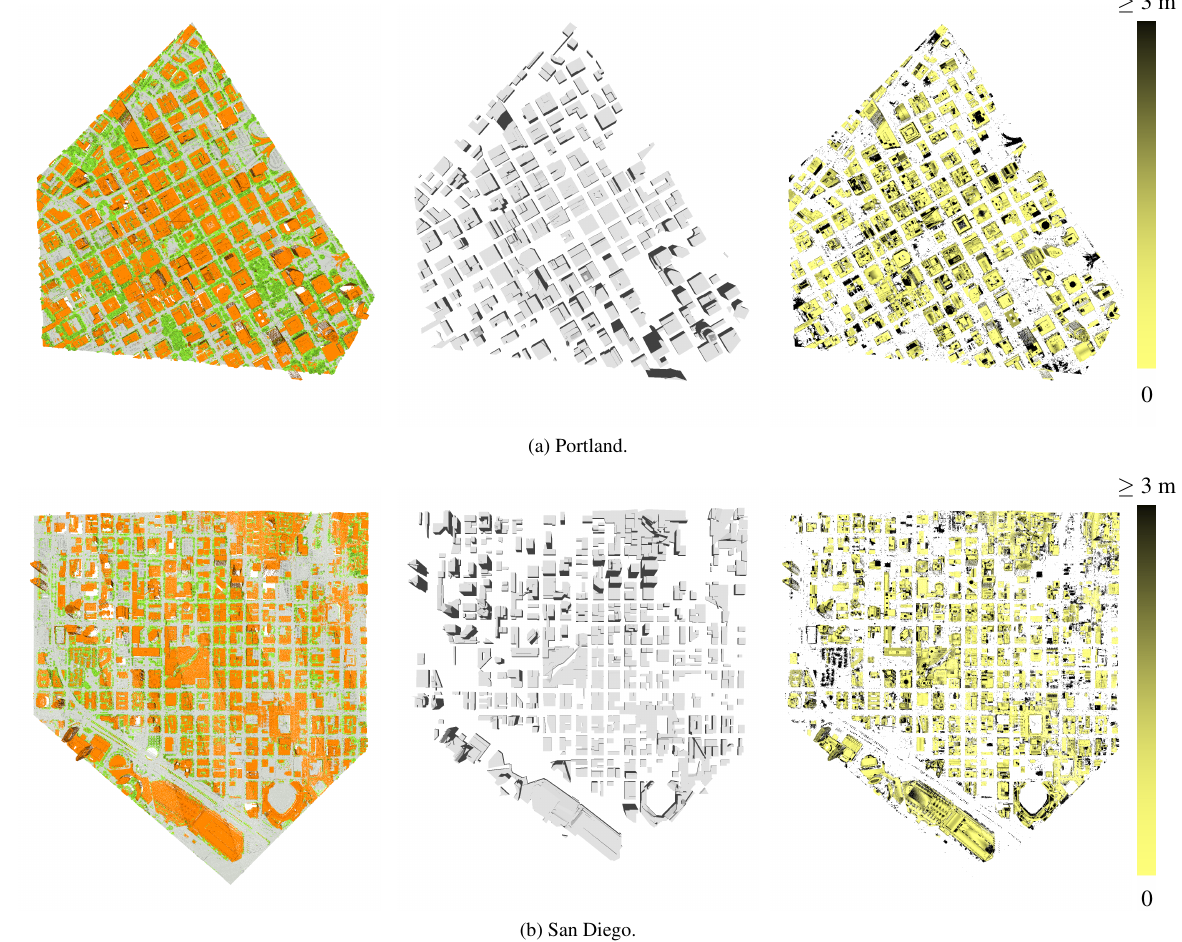
Figure 3. Results on American-style urban landscapes. Some close-ups are showed in Figures 4 and 5.